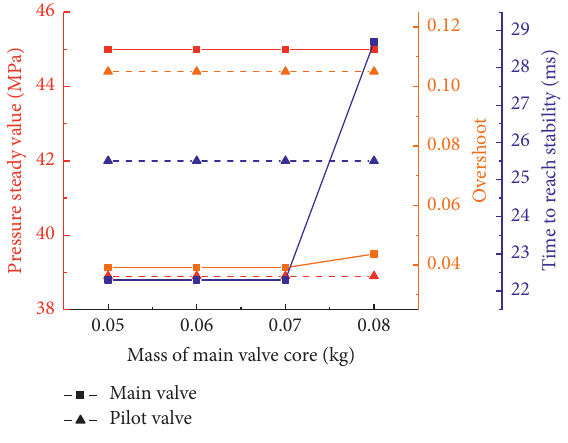
Figure 15: Dynamic response